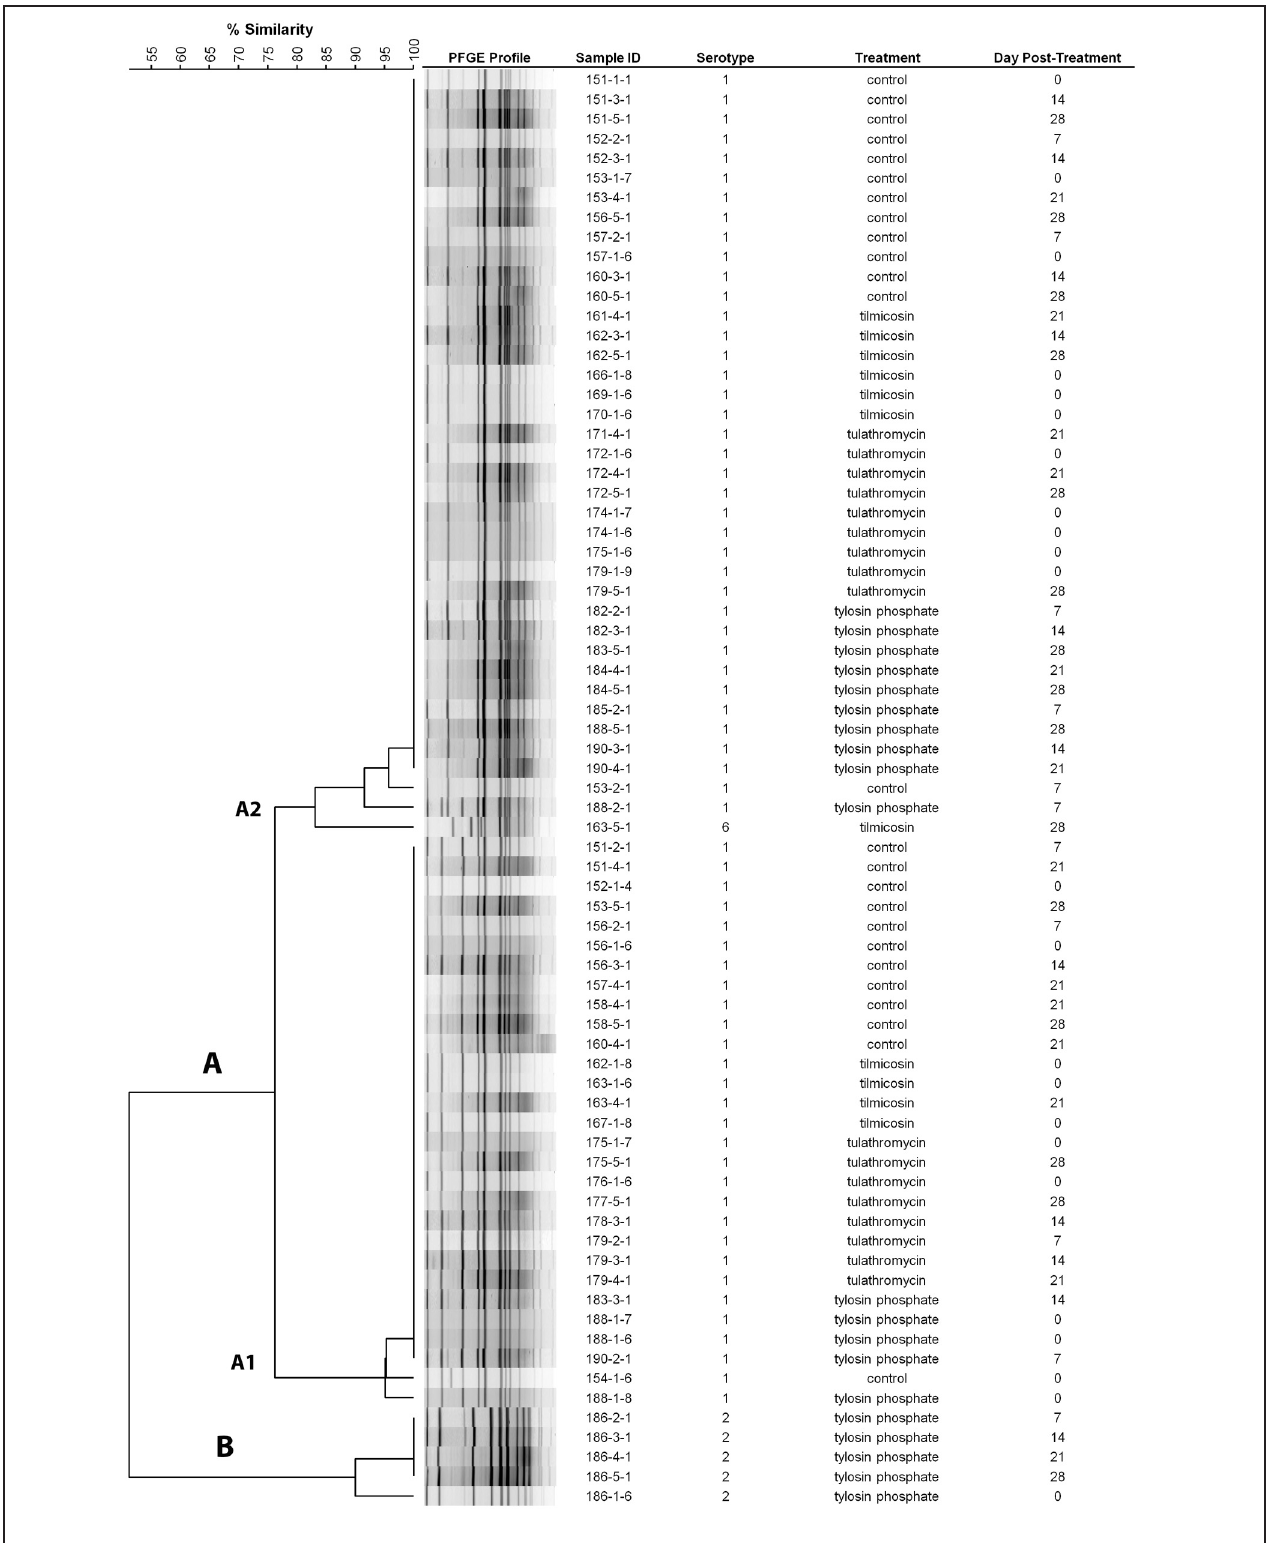
FIGURE 2 | Dendrogram of PFGE Sal I profiles from representative M. haemolytica isolates collected weekly. As an example, sample ID 151-3-1 represents isolate #1 from 3rd sampling event (day 14 post